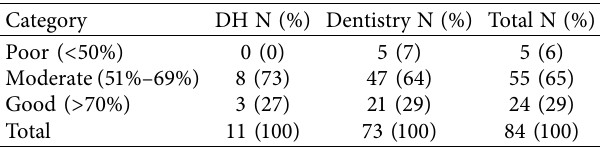
Table 3: The number of students to score between certain thresholds for the theoretical knowledge score ( n � 84).